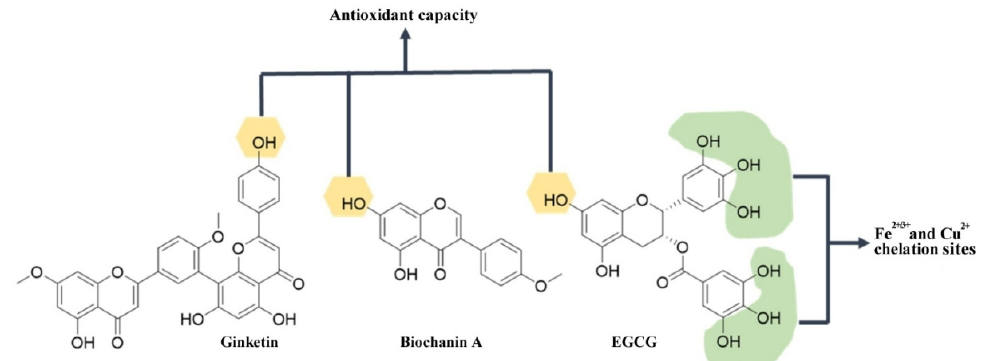
Figure 3. Structure of flavonoids with neuroprotective activity. Green shadowing shows iron chelation sites; yellow shadowing shows free radical scavenger sites.